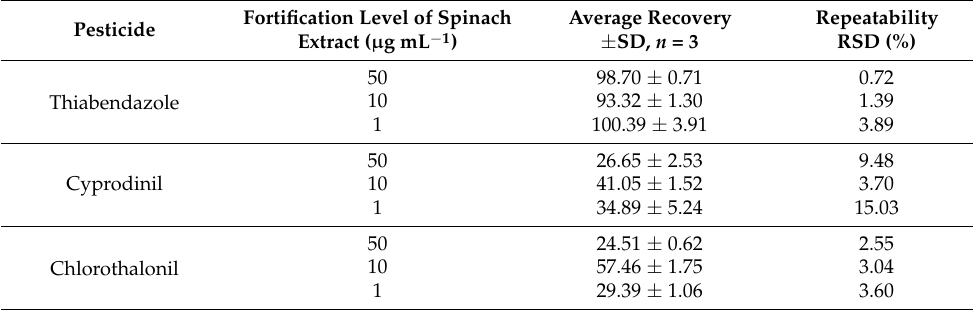
Table 3. Average recoveries of investigated pesticides and %RSD values.